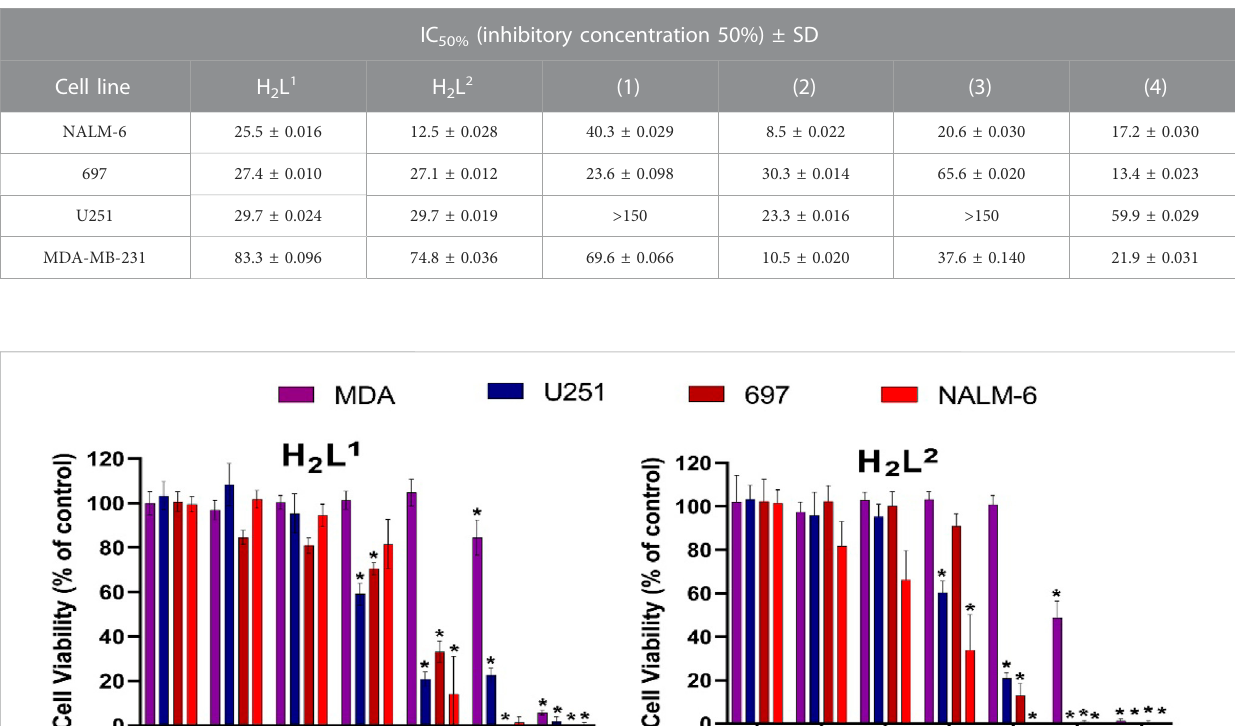
TABLE 3 Cytotoxic activity of the ligands H 2 L 1 and H 2 L 2 and the complexes (1 – 4). The results are presented as the inhibition concentration that causes a 50% decrease in cell growth (IC 50 ) against cancer cells (values estimated by non-linear regression of data from viability assessment).